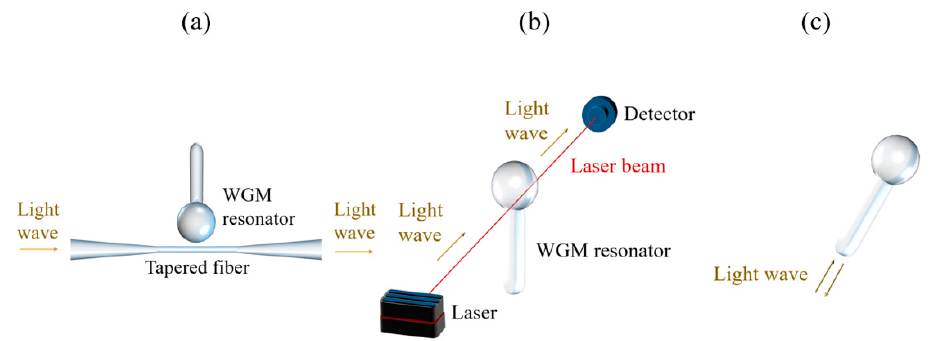
Figure 1. Schematics of the signal detection system of whispering gallery mode (WGM) microresonator. ( a ) Sketch of an optical WGM microresonator coupled to a tapered fiber [24], where the input light was guided inside the tapered fiber from one end, and the resulting signal was detected at another end. ( b ) WGM biosensor platform, where input optics guided the light beam through the resonator, which was then detected at output optics [25]. ( c ) The detection system presented in this work was based on input light being guided inside the ball resonator, and the resulting back-reflected output signal was detected.